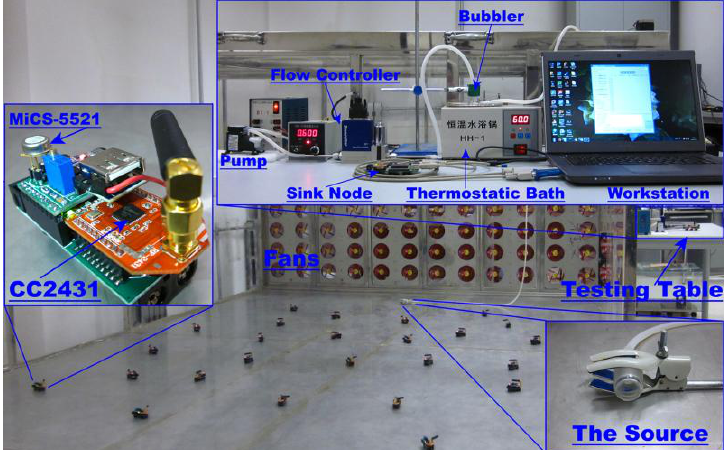
Figure 10. The general picture of the experimental installations. The bubbler was kept in a thermostatic bath so as to keep pressure inside the bubbler at a constant saturated vapor pressure. The pump and the flow controller were used to blow the saturated ethanol vapor out from the bubbler into the wind tunnel through a long PVC